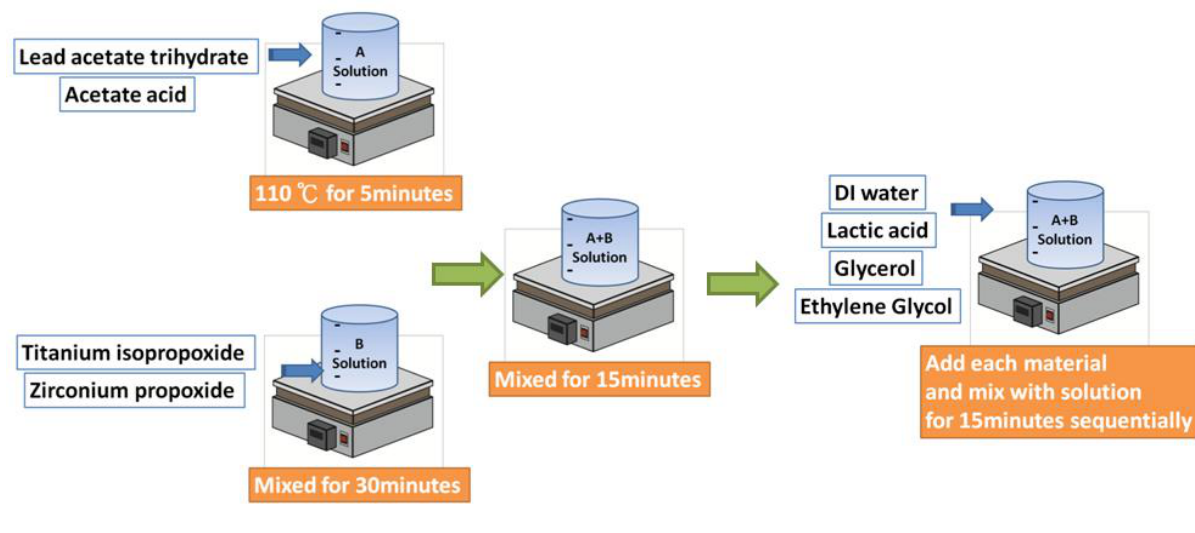
Figure 1. Preparation process of PZT solution